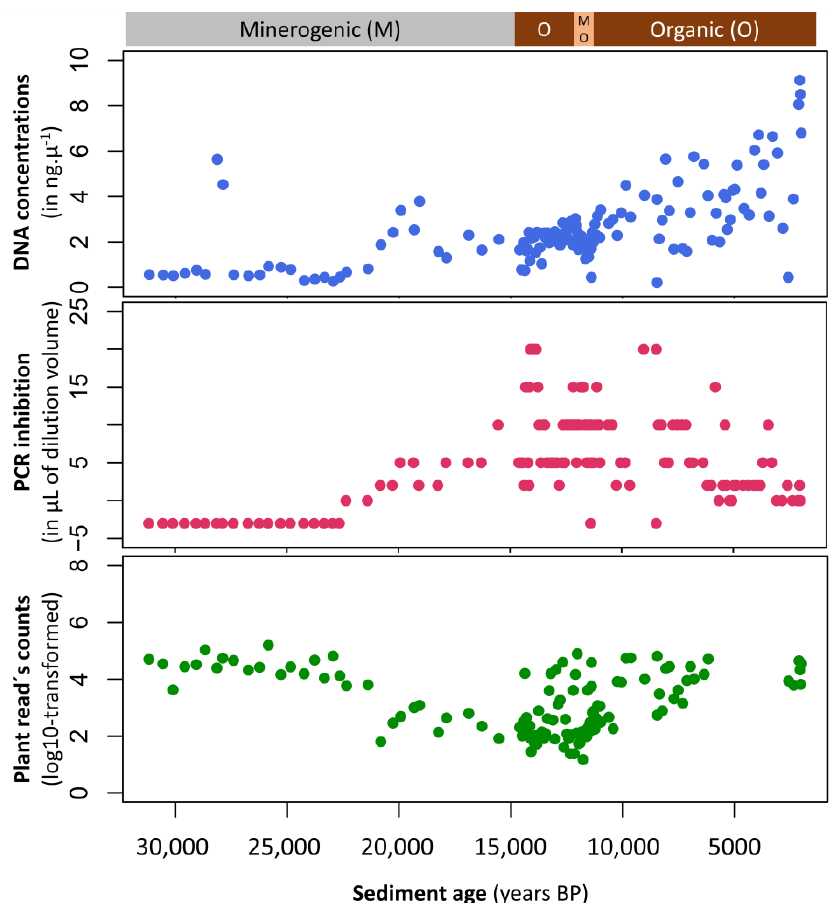
Figure 2. The plot shows three measures of DNA extraction/amplification quality with time on the x -axis (years before present (BP)). The first plot (blue dots) shows the DNA concentration (ng. µ L − 1 ) with a moderate to strongly negative correlation with age. The second plot (pink dots) shows the PCR inhibition as the dilution volume (in µ L) necessary for qPCR reactions to succeed. Inhibition is absent until ~23,000 years BP and increases steadily afterwards. The third plot (green dots) shows the log 10 of the mean number of raw reads from plant DNA metabarcoding. The number of reads is strongly and negatively correlated to the level of inhibition (see Appendix A). A simplified description of sediment lithology is provided at the top of the figure: minerogenic (M), organic (O), and minerogenic–organic (MO) sediment types.